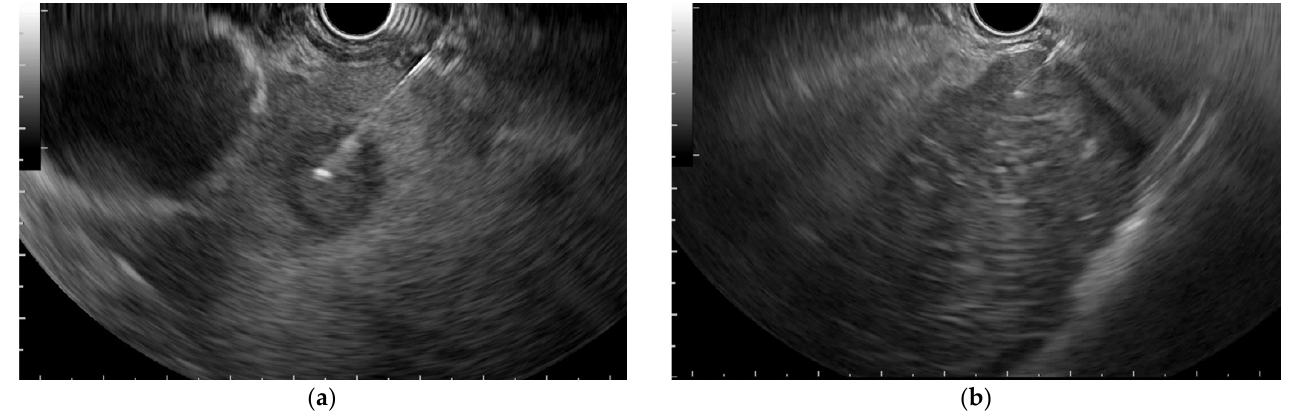
Figure 1. Endoscopic ultrasound tissue acquisition. ( a ) Hepatic metastasis of pancreatic adenocarcinoma; ( b ) hepatocarcinoma.